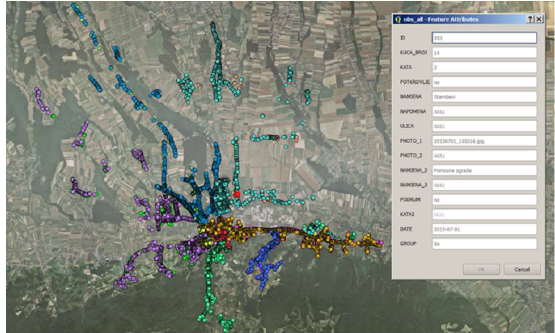
Figure 6. Geographic distributions of all observations collected by working groups and example of attributes for selected